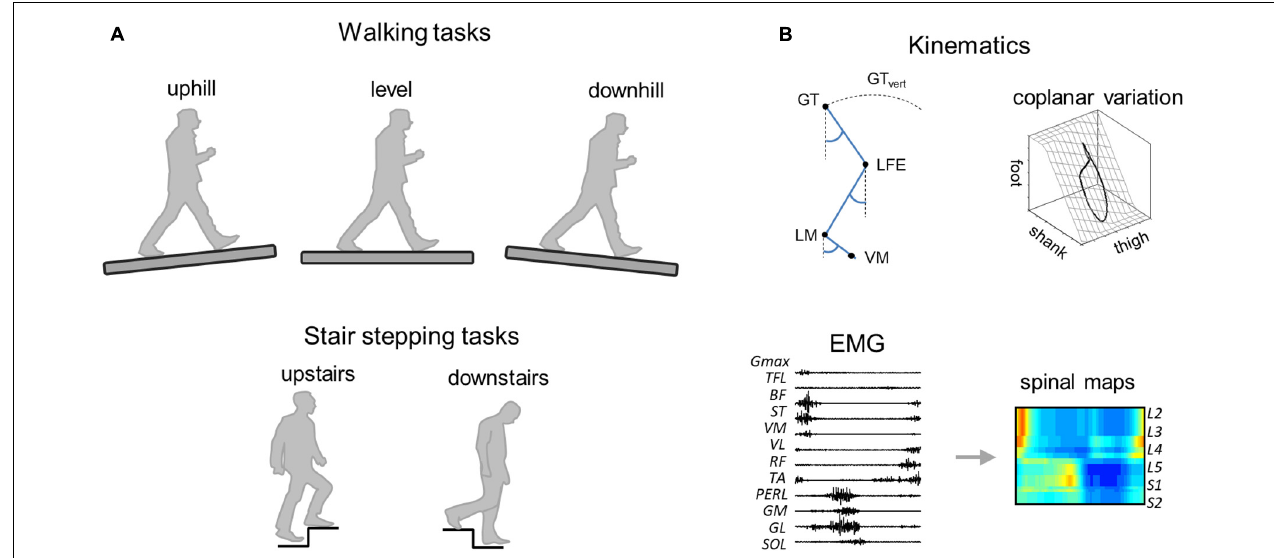
FIGURE 1 | Methodological figure. (A) Walking (uphill, level, and downhill) and stair stepping (upstairs and downstairs) tasks. (B) Data analysis. GT, greater trochanter; LFE, lateral femoral epicondyle; LM, lateral malleolus; VM, fifth metatarso-phalangeal joint, and GT vert , vertical displacement of GT.